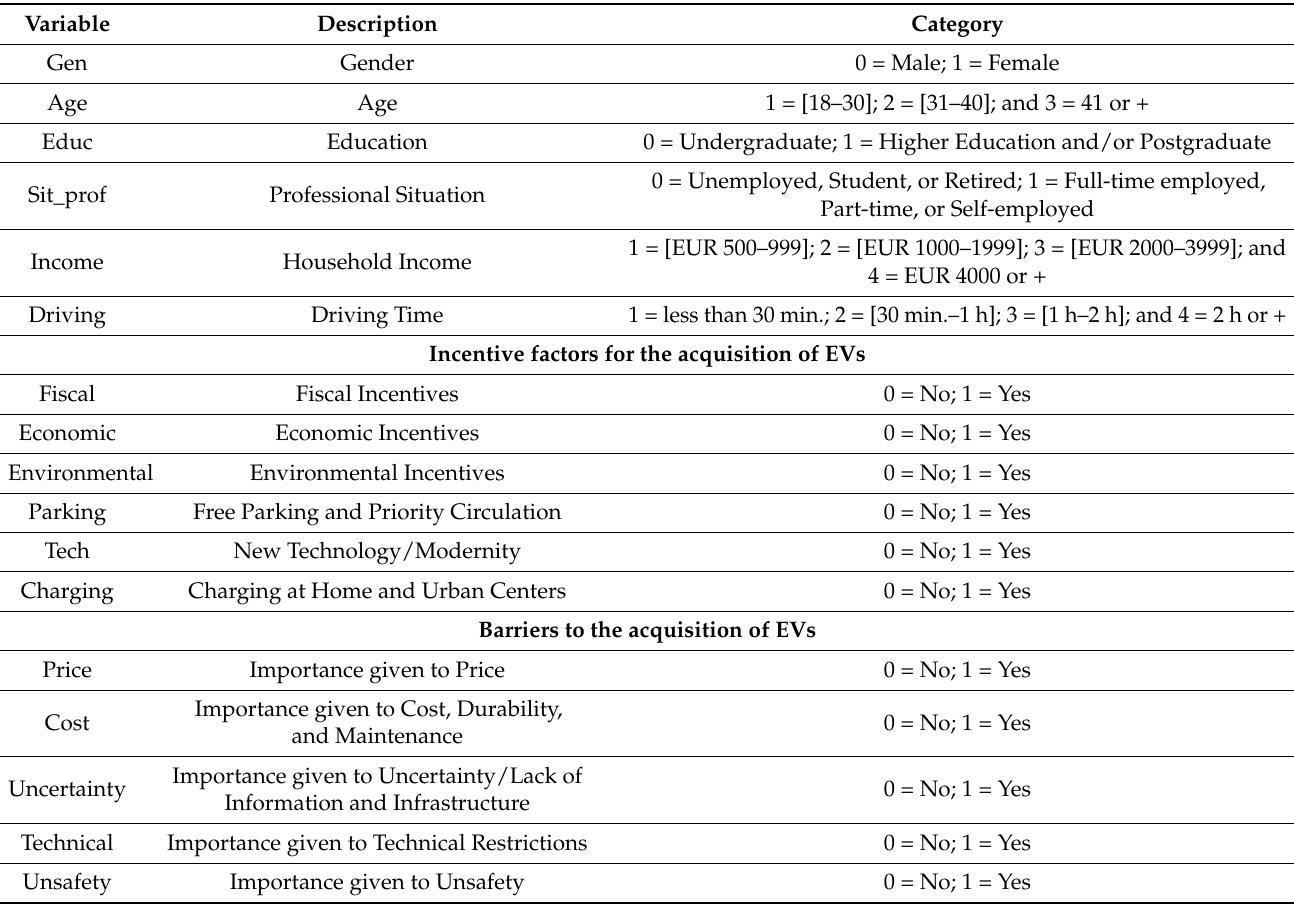
Table 3. Description of the variables used in the